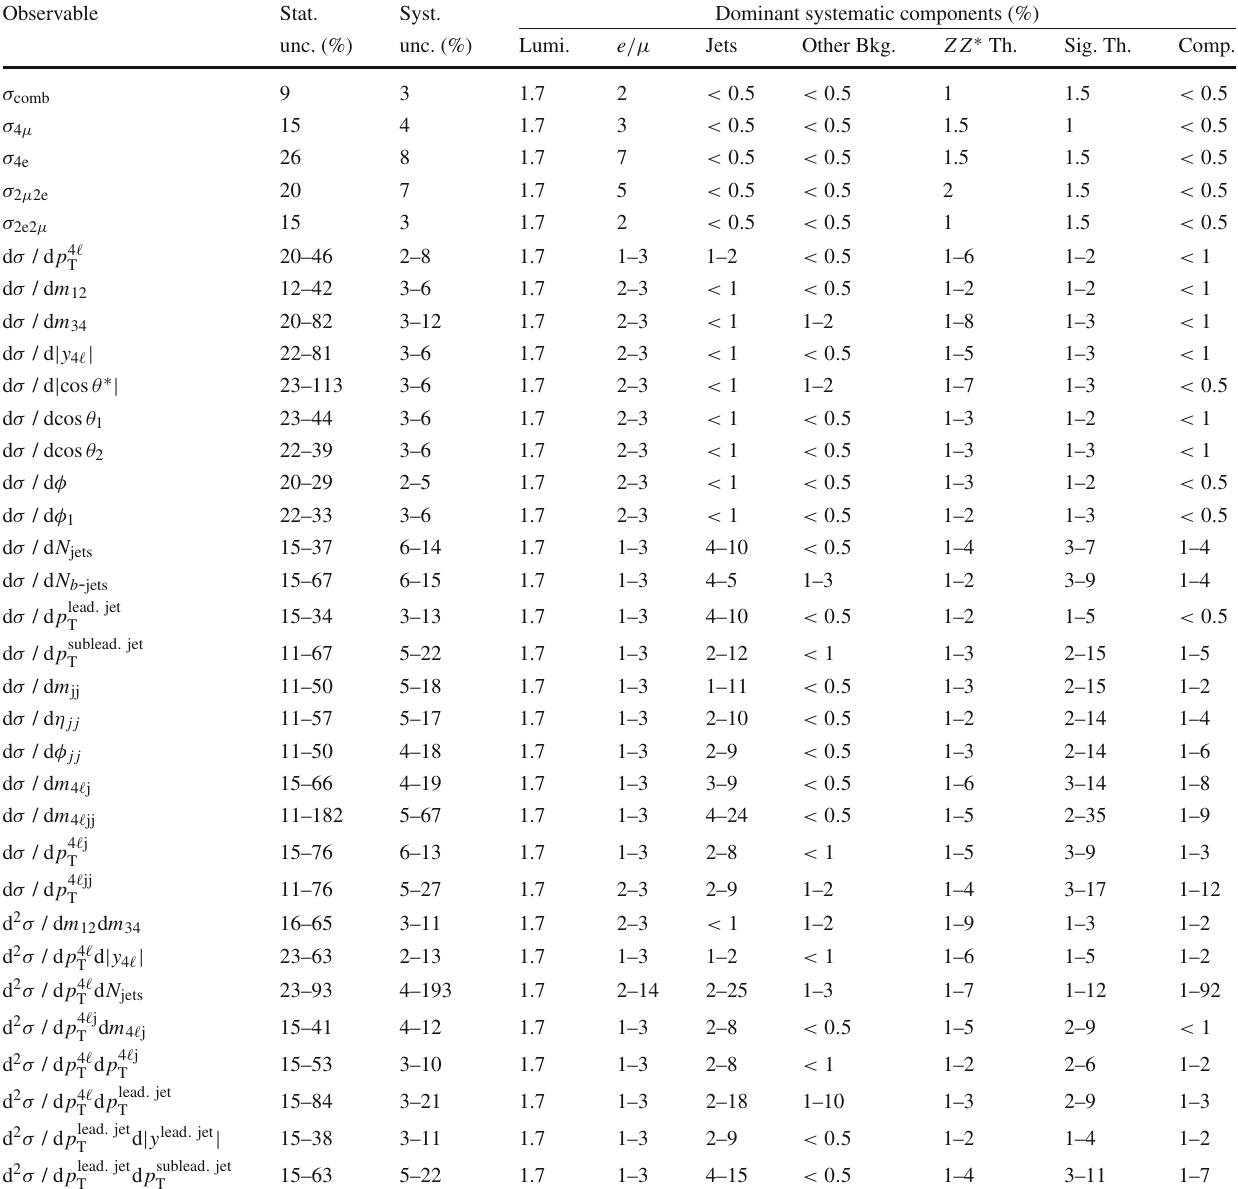
Table 5 Fractional uncertainties for the inclusive fiducial and total cross sections, and ranges of systematic uncertainties for the differen- tial measurements. The columns ‘ e /μ ’ and ‘Jets’ represent the exper- imental uncertainties in lepton and jet reconstruction and identifica- tion, respectively. The Z + jets, t ¯ t , tX X (Other Bkg.) column includes uncertainties related to the estimation of these background sources. The Z Z ∗ theory ( Z Z ∗ th.) uncertainties include the PDF and scale varia-